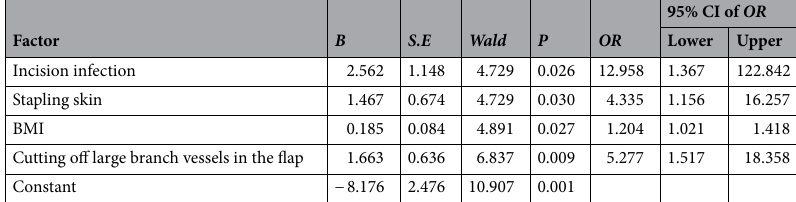
Table 4. Binomial multivariate logistic regression analysis of poor incision healing.